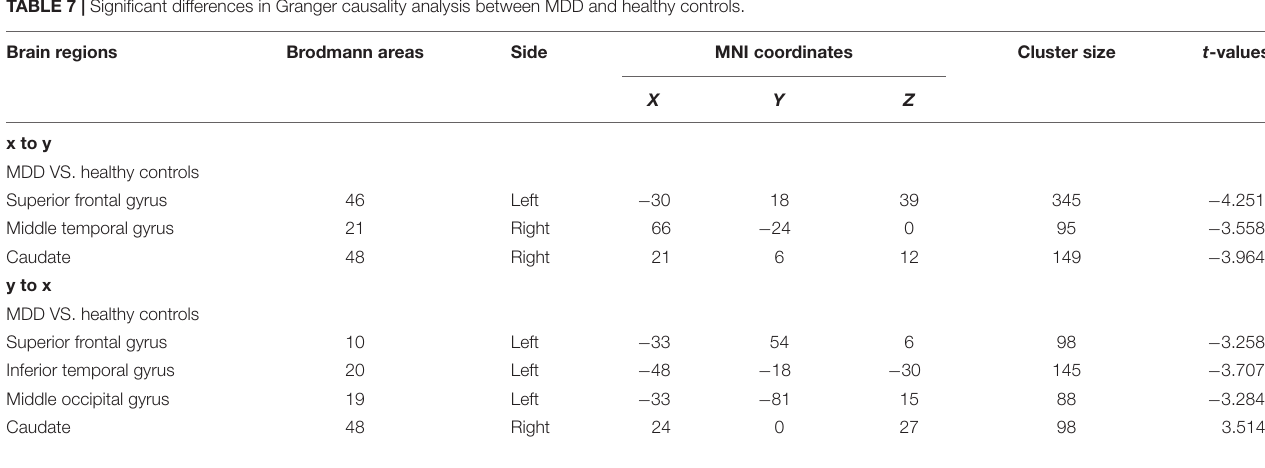
TABLE 7 | Significant differences in Granger causality analysis between MDD and healthy controls. Brain